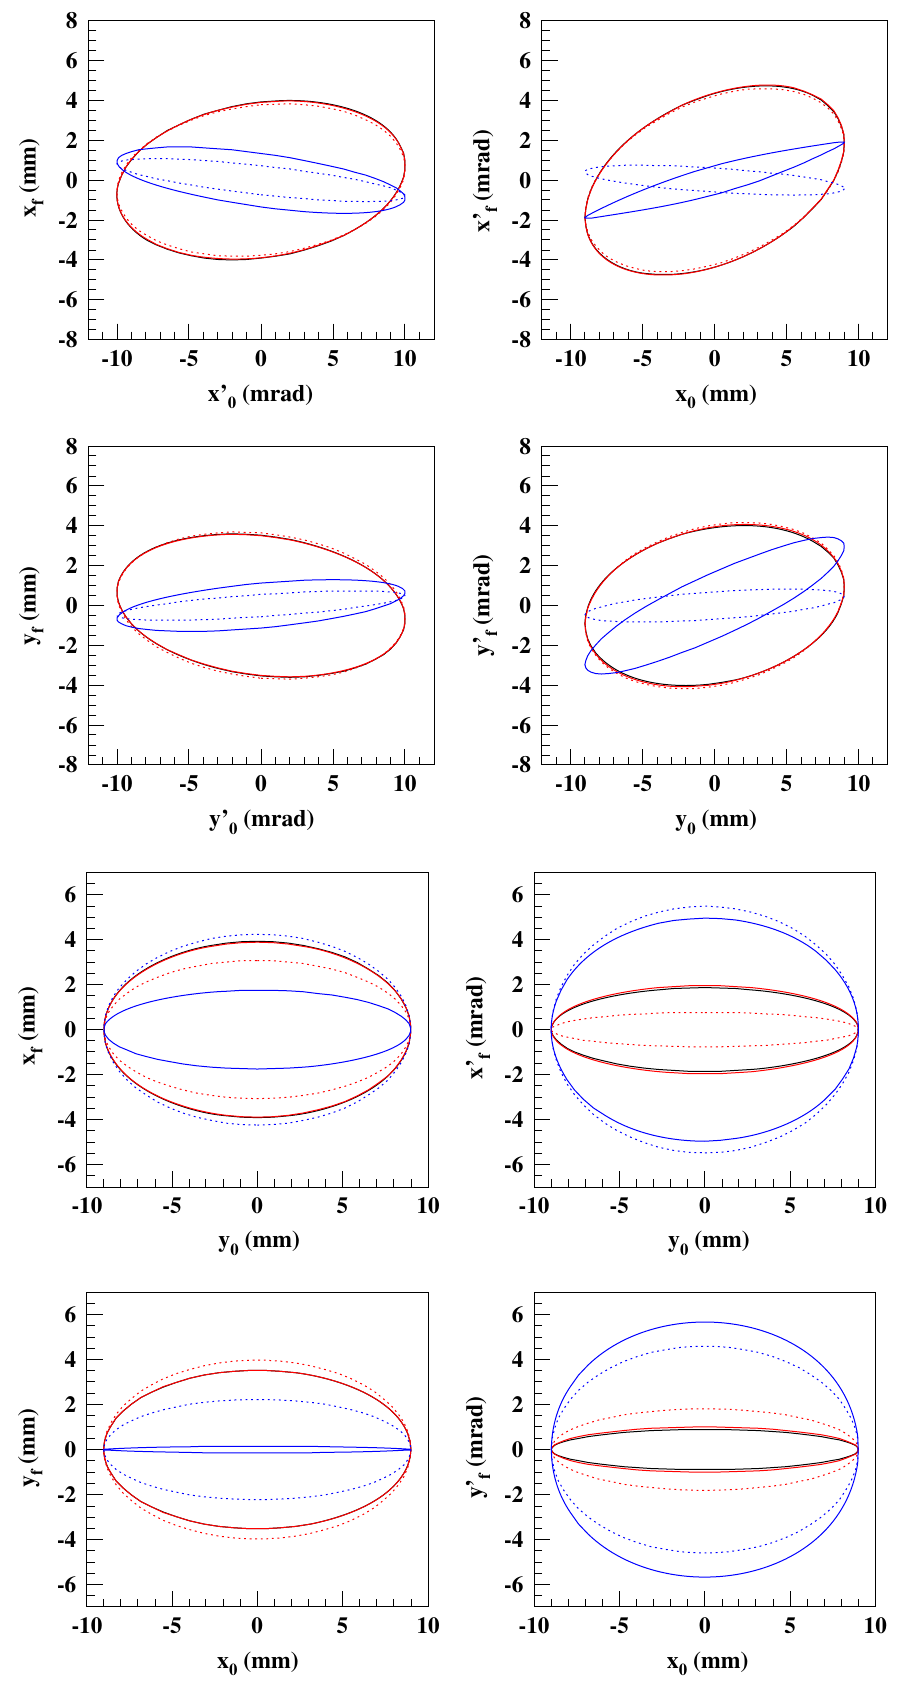
FIG. 5. The same initial condi- tions, color code, and line type as Fig. 4, this time computed for two steps. We see that, in comparison to Fig. 4, the errors in case of the low- order expansion (dashed blue curves) are significantly reduced. The errors with more expansion orders (solid blue curves) improve only slightly.